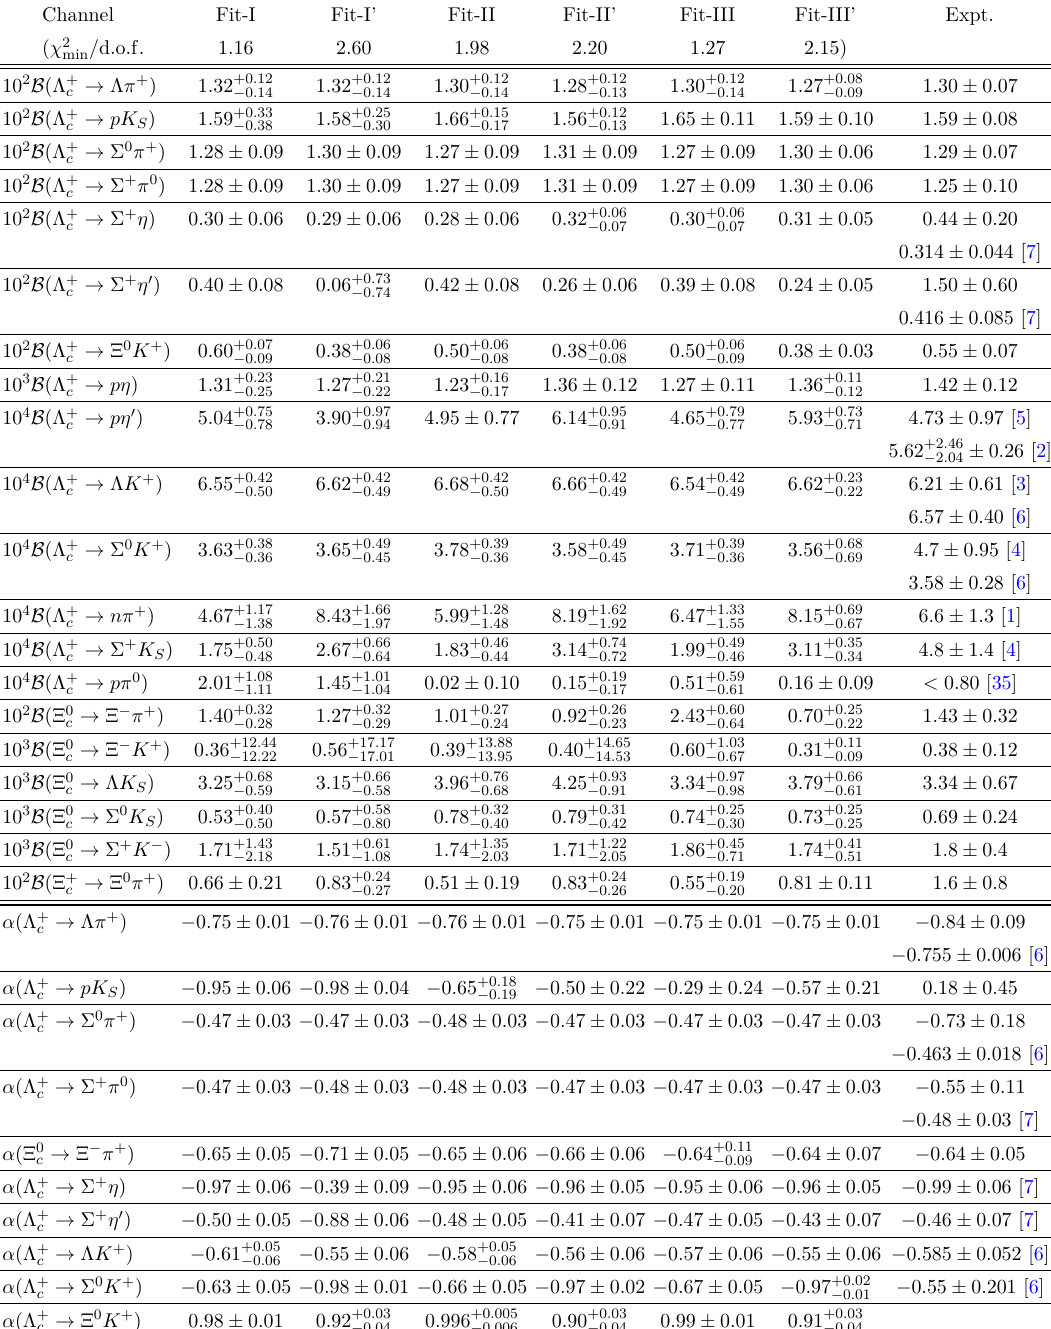
Table 9 . Predictions of branching fractions and decay asymmetries in different schemes, in which the scheme with a prime stands for the SU (3) respected scenario while these without a prime containing SU (3) breaking effect. The corresponding experimental values for a comparison are given in the last